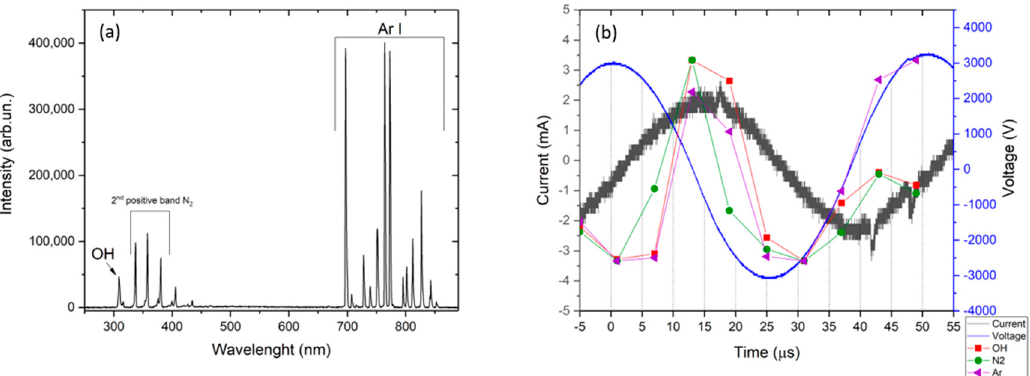
Figure 2. Broad-range emission spectrum of Ar plasma operated above a non-grounded water target ( a ) and time-resolved optical emission spectroscopy (OES) during one period ( b ).